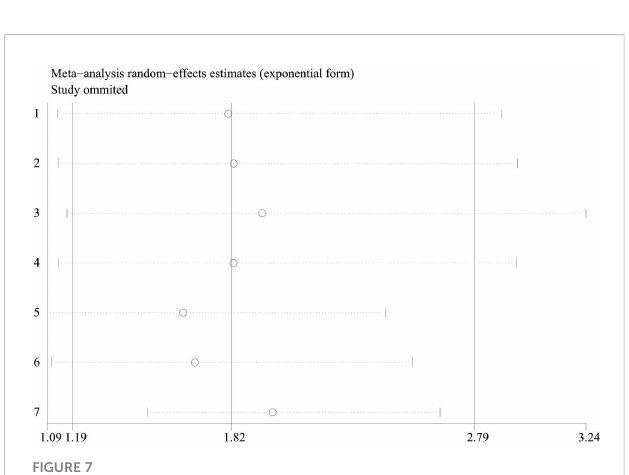
FIGURE 7 Sensitivity analysis (CSS in prostate cancer). CSS, cancer-speci fi c survival.